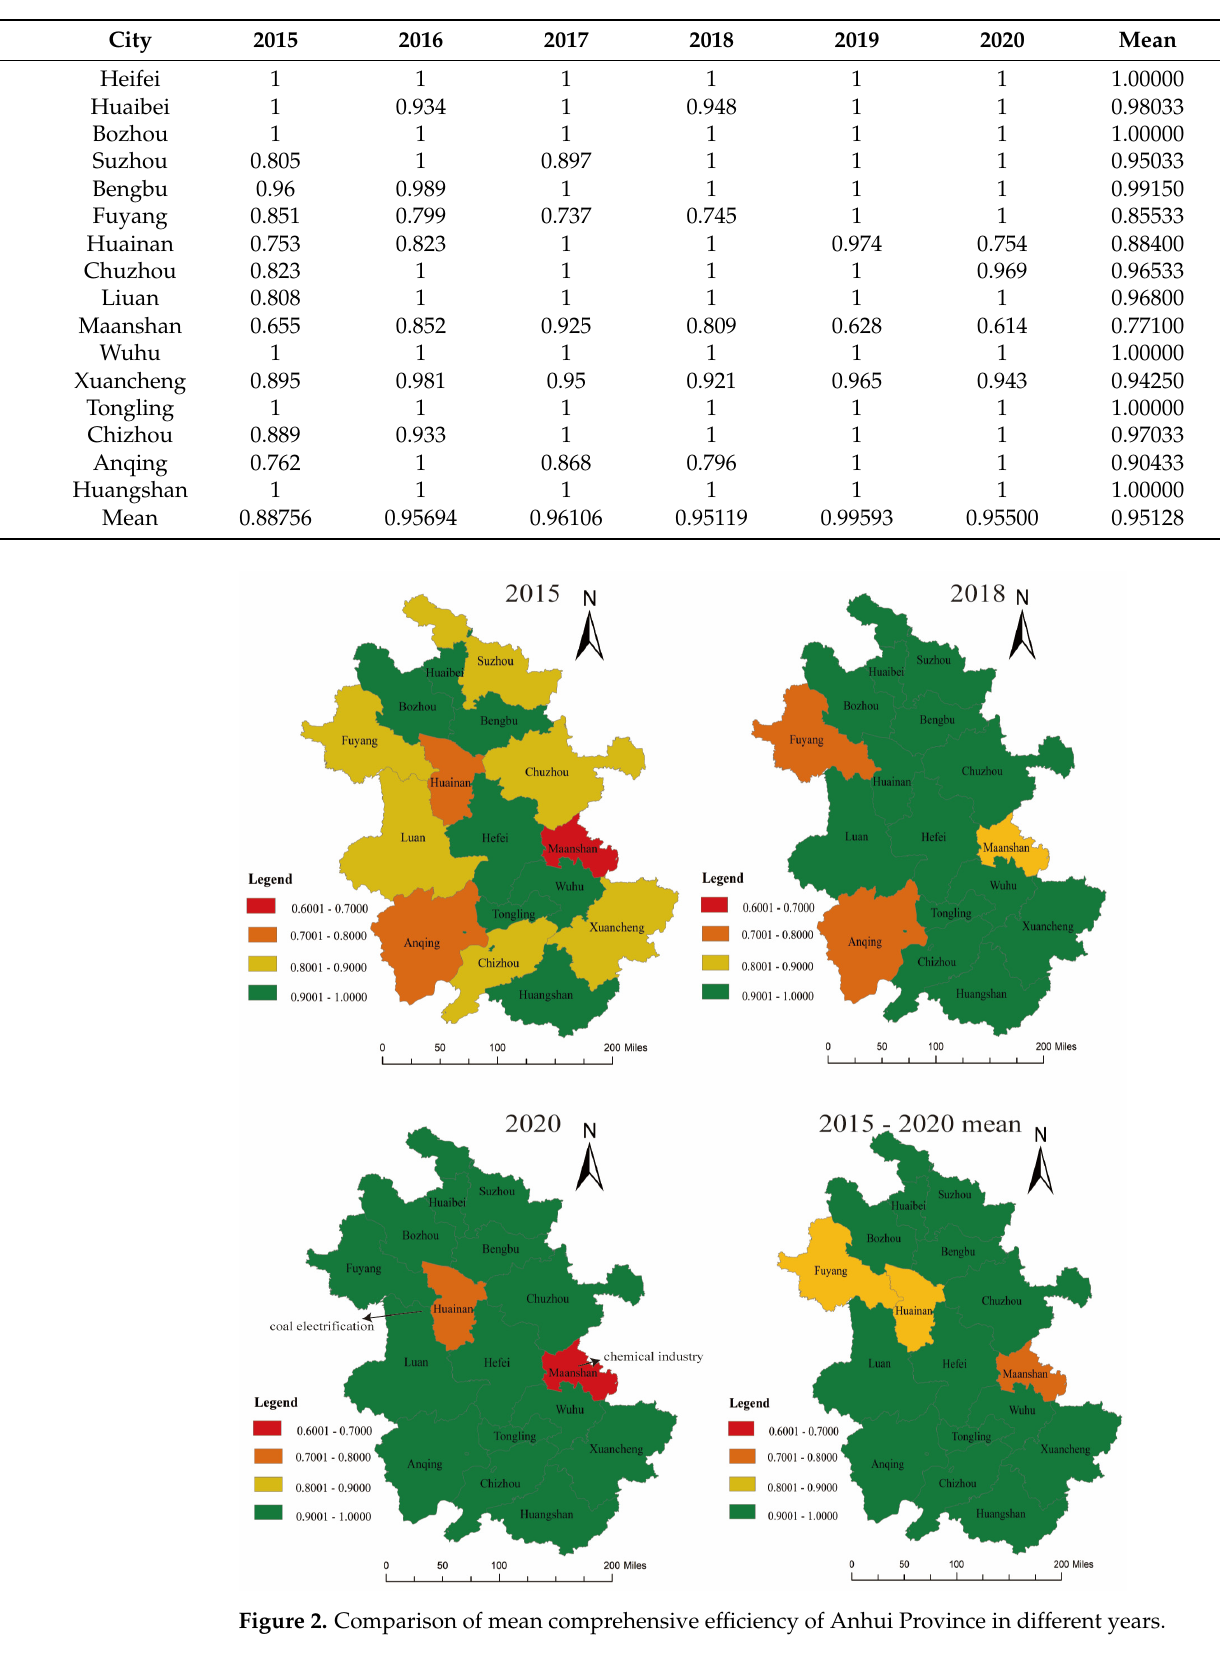
Table 3. Comprehensive eco-efficiency of the RLI in Anhui Province (2015–2020).